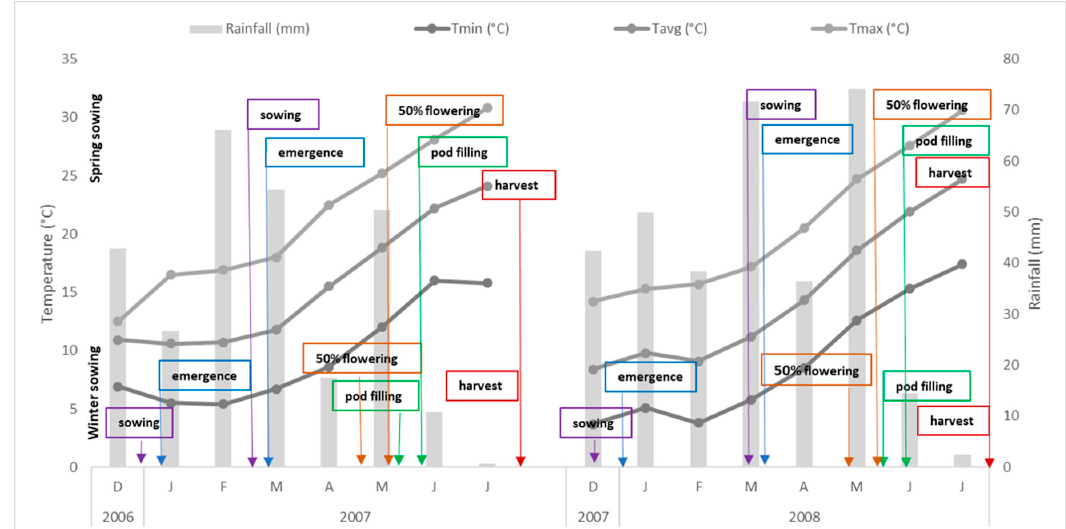
Figure 1. Weather pattern and phenological stages of chickpea during the two growing seasons. Downward labels are referred to winter sowing (E1); upward labels are referred to spring sowing